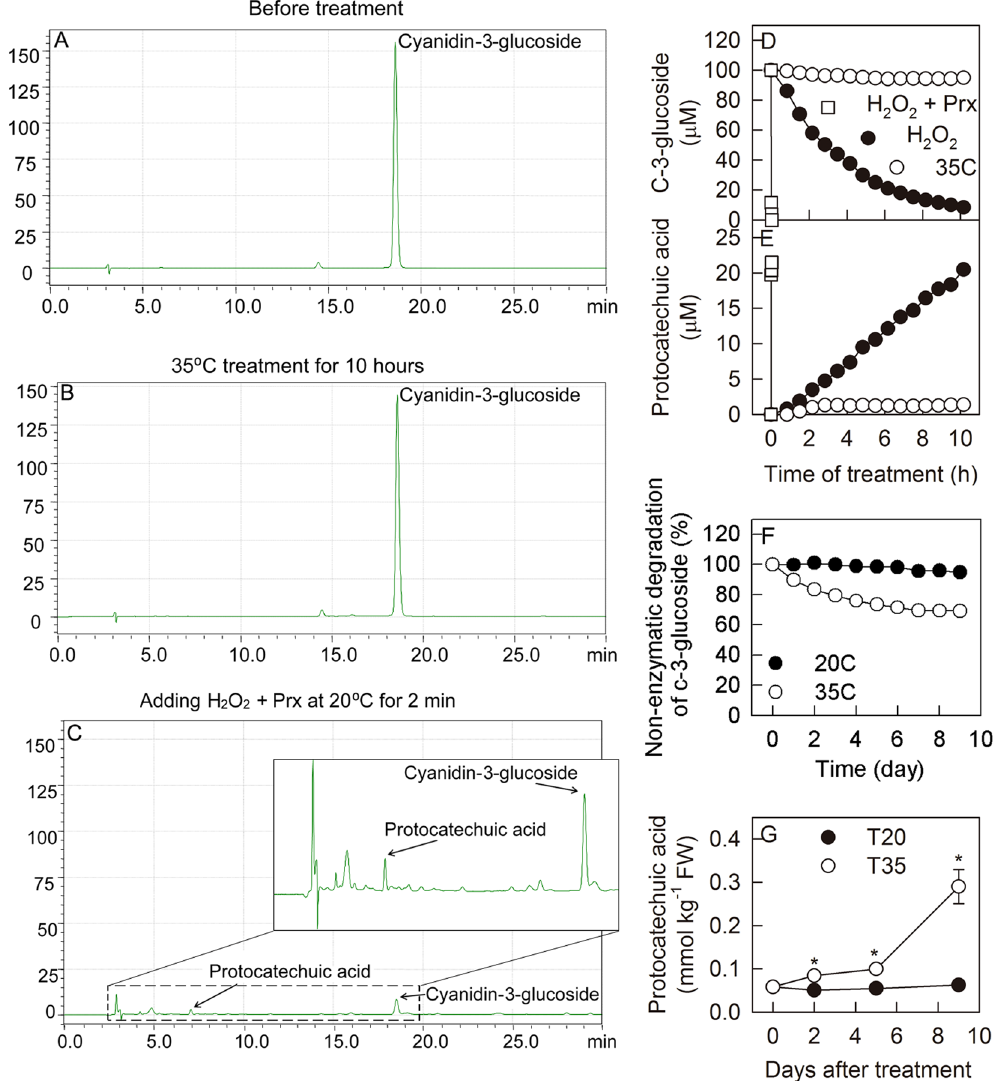
Figure 6. Degradation of anthocyanin. Panel A–C, chromatogram of cyandin-3-glucoside with non-enzymatic or enzymatic degradation induced by hydrogen peroxide; Panel D and E, changes of cyanidin-3-glucoside concentration and production of protocatechuic acid during non-enzymatic degradation or after adding hydrogen peroxide with or without horseradish peroxidase at pH 4.0. Panel F, non-enzymatic degradation of cyanidin-3-glucoside at 20 °C and 35 °C at pH 4.0; Panel G, concentrations of protocatechuic acid in the peel of plum fruits treated at 20 °C and 35 °C for different time in the dark. Each data point represents mean ± SE (n = 5). The asterisk indicates a significant difference between two temperature treatments at P < 0.05, t